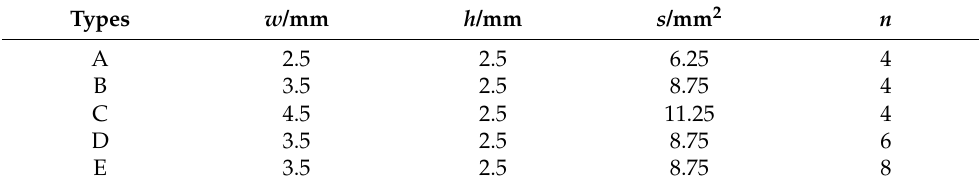
Figure 2. Projectiles: ( a ) structural diagram; ( b ) physical map. Table 1. Structural parameters of the